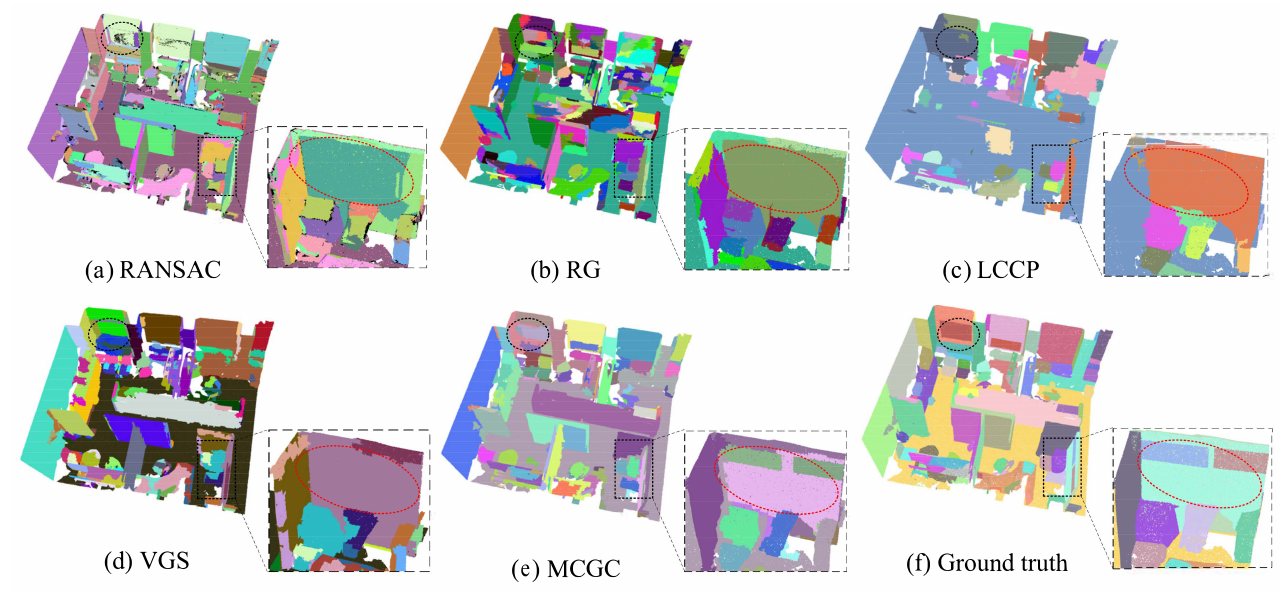
Figure 11. The visual comparison of the office-2 by different methods. One local scene slice which is selected to enlarge the segments in the black box. ( a ) The result from RANSAC. ( b ) The result from RG. ( c ) The result from LCCP. ( d ) The result from VGS. ( e ) The result from MCGC. ( f ) The ground truth.